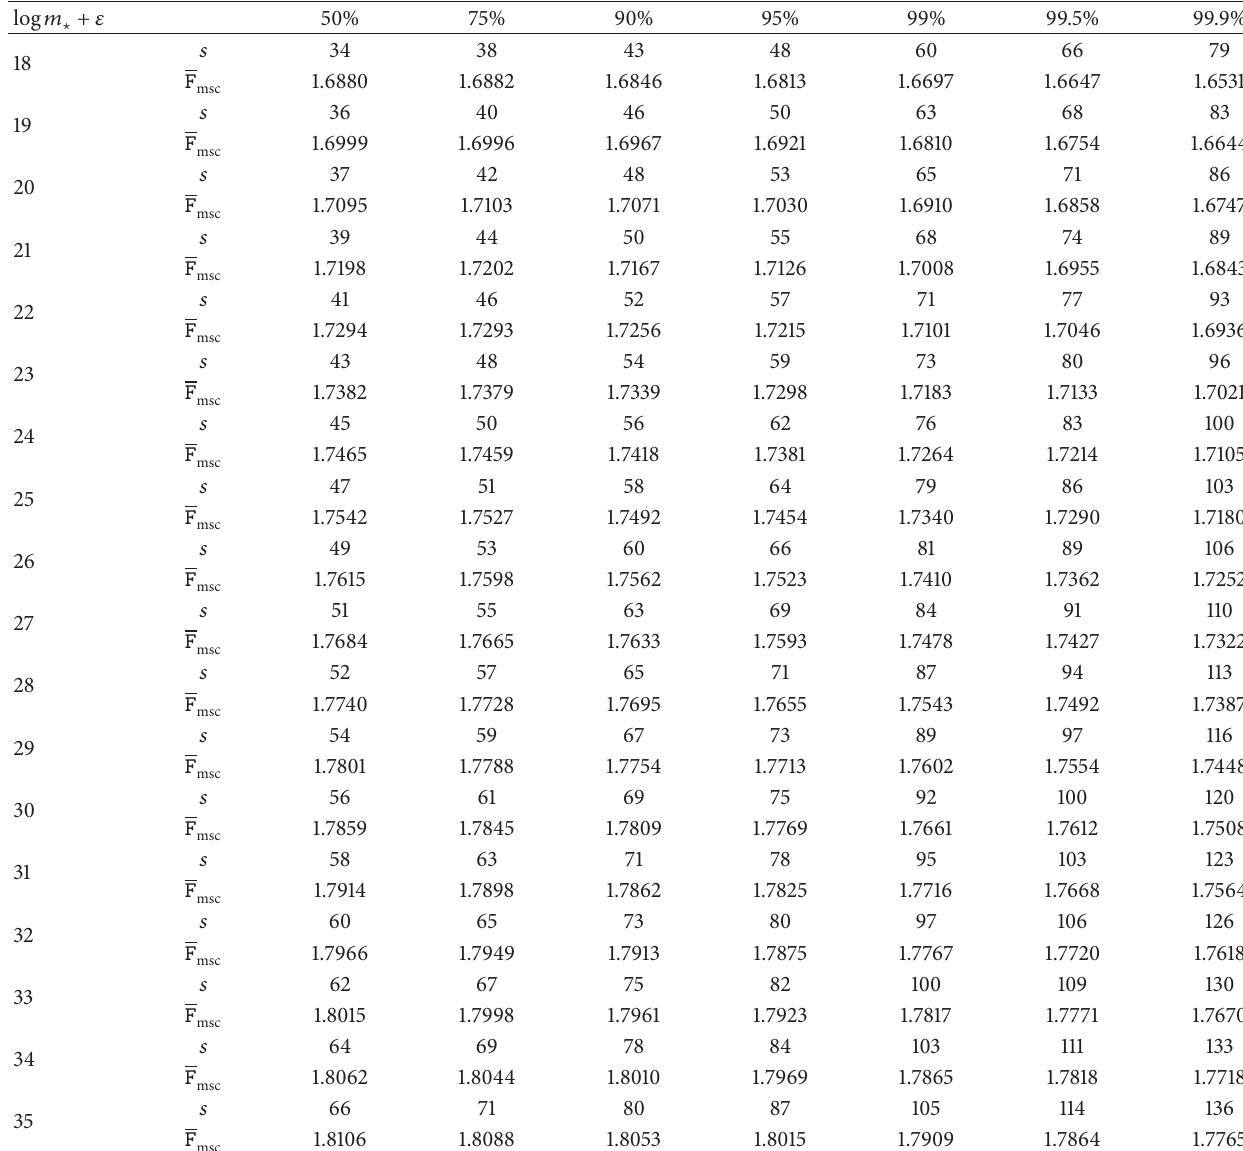
Table 1: Optimal 𝑠 for the perfect fuzzy rainbow tradeoff, at various F minimum F atc, 𝑠